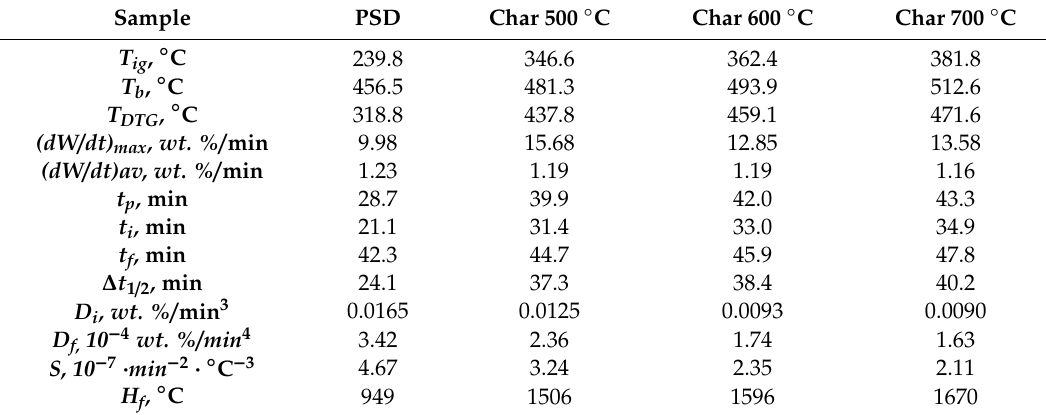
Table 2. Main combustion parameters of pine sawdust (PSD) and